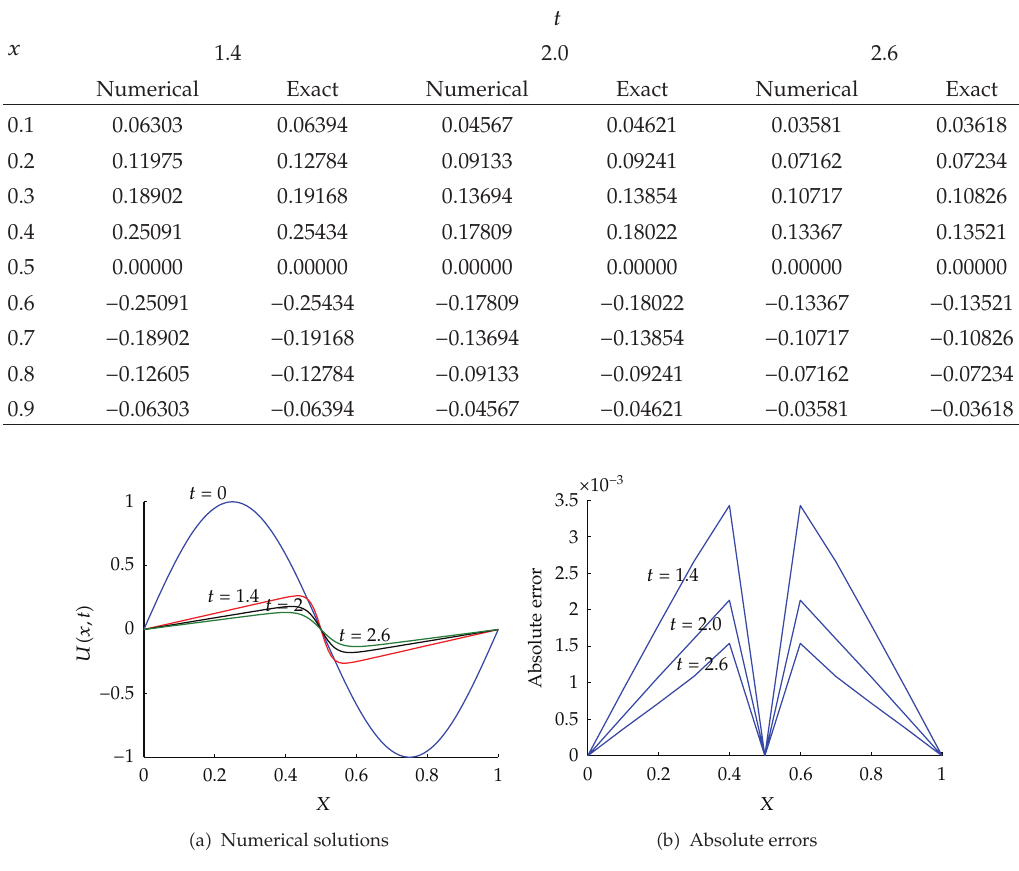
Figure 2: Numerical solutions (cid:3) a (cid:4) and distribution of absolute errors (cid:3) b (cid:4) for ν (cid:8) 0 . 005 at di ff erent times with dx (cid:8) 0 . 005 , τ (cid:8) 1 . 1, and dt (cid:8) 0 .